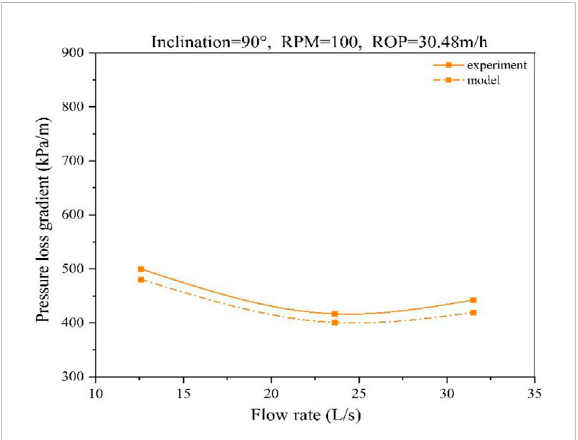
FIGURE 12 Pressure loss gradient at 90 ° , 30.48 m/h, and 100 RPM.